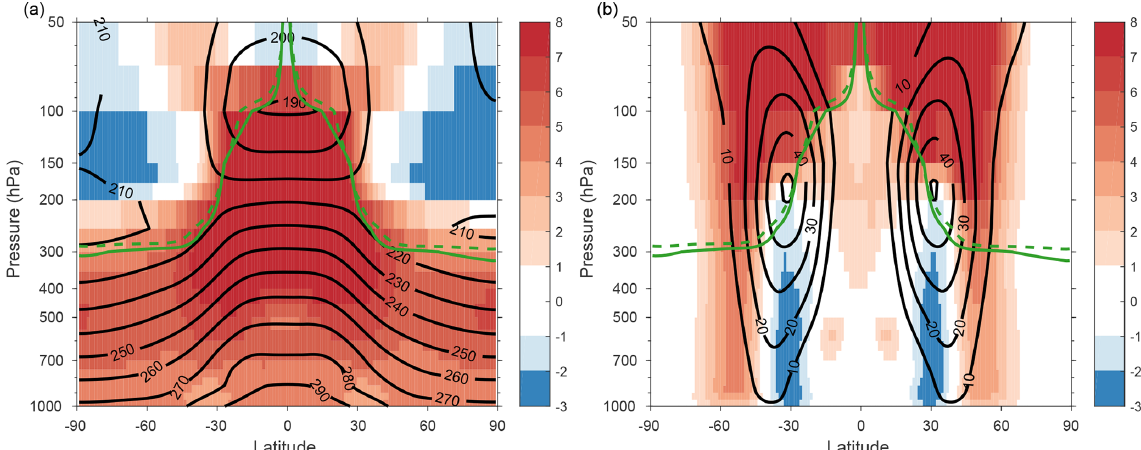
Figure 1. Zonal mean (a) temperature (K) and (b) zonal winds (ms − 1 ) averaged over 10 years of simulation. Black contours show the CNTL simulation and shading the difference between the SST4 and control simulations (SST4 − CNTL). The green solid line shows the dynamic tropopause (the 2PVU surface) in CNTL and the dashed line in